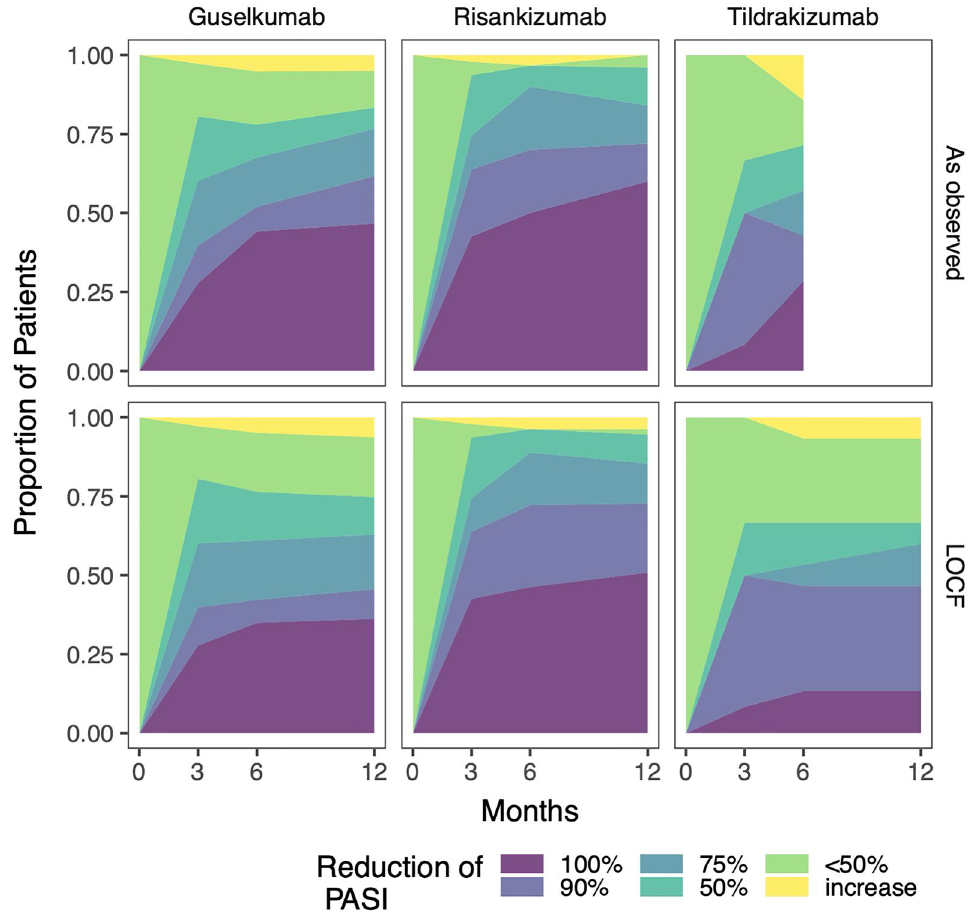
Figure 2. Achievement of skin goals. Relative number of patients analysed as observed and per last observation carried forward (LOCF), in whom a certain Psoriasis Area and Severity Index (PASI) was achieved, plotted over